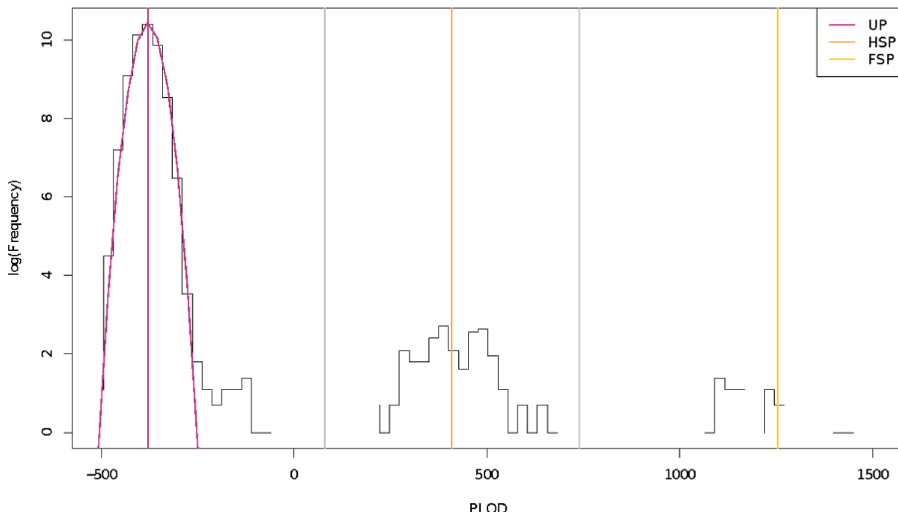
Figure 2. Psuedo-log-odds-ratios (PLOD) from the program "kinference" (Bravington et al., in prep) for discrimination of kinship pairs (half-siblings and full-siblings), on a vertical log scale. The vertical orange and yellow lines give the a priori expected mean PLOD for half-sibling pairs (HSP) and full-sibling pairs (FSP), respectively. The purple curve indicates the a priori expected distribution of unrelated pairs (UP), with its mean marked by the purple vertical line. The cutoffs between unrelated pairs, half-sibling pairs, and full-sibling pairs are denoted by gray vertical lines.